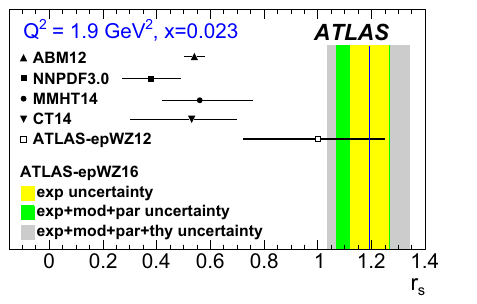
give the predictions from different NNLO PDF sets; open square show the previous ATLAS result [38]. The ratios are calculated at the initial = 1 . 9 GeV 2 and at x = 0 . 023 corresponding to the point of scale Q 2 0 largest sensitivity at central rapidity of the ATLAS data